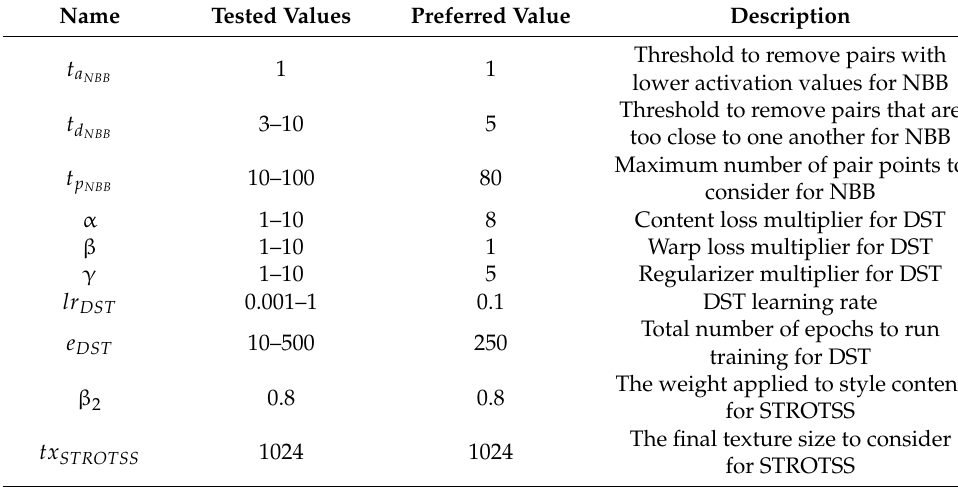
Table 1. Different hyperparameters used in our framework.